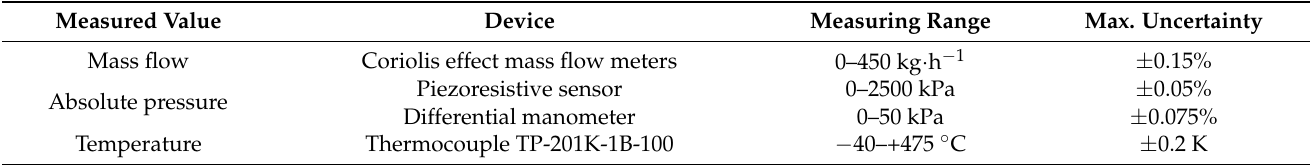
Table 1. Measurement uncertainty of the equipment used to measure the refrigerant condensation process in the heat